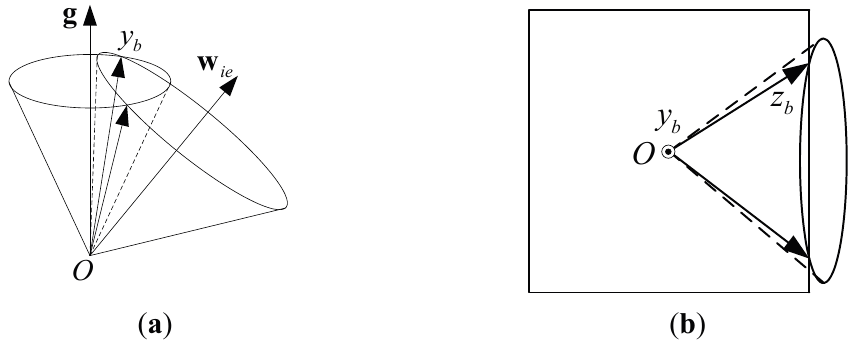
Figure 2. Existence of the selective alignment solution: ( a ) Two lines that represent the y -axis will be formed by the intersections of the two conical surfaces; ( b ) Two lines that b z -axis will be formed by the intersection of a plane and a conical surface. represent the b